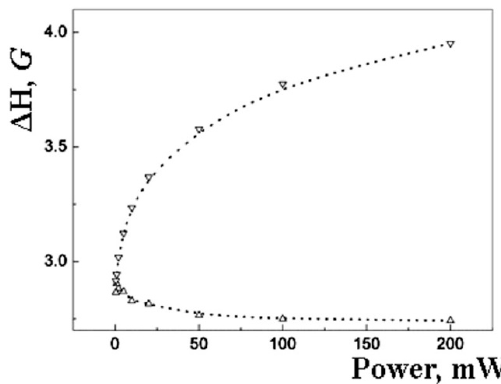
Figure 8. Dependence of the width of the EPR signal components (Lorentians) of palladium nanoparticles in a sample with 10 wt% microwave power (room temperature). Circles are experimental points; dotted lines are parameters of the calculated Lorentzians.